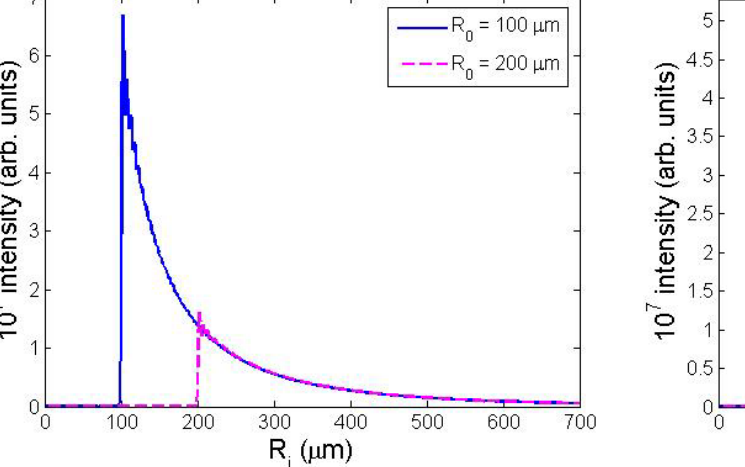
FIG. 4. (Color) PSF of the ODR generated from a large radius circular aperture. The parameters used are (cid:3) (cid:3) 10 000 , (cid:4) (cid:3) 0 : 5 (cid:8) m , and M (cid:3) 1 .